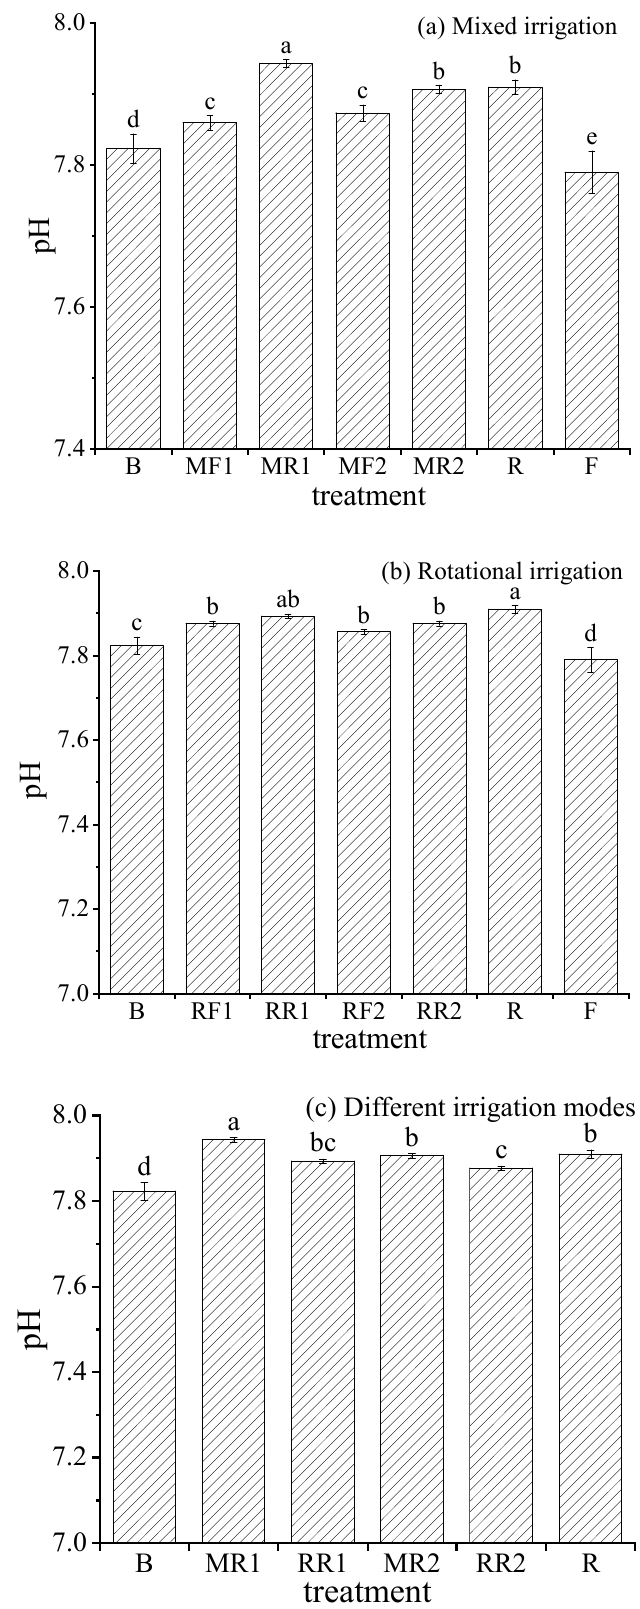
Figure 3. Variation in soil pH value under different irrigation scenarios. Note: different lowercase letters on the bars represent the significant differences at the level of